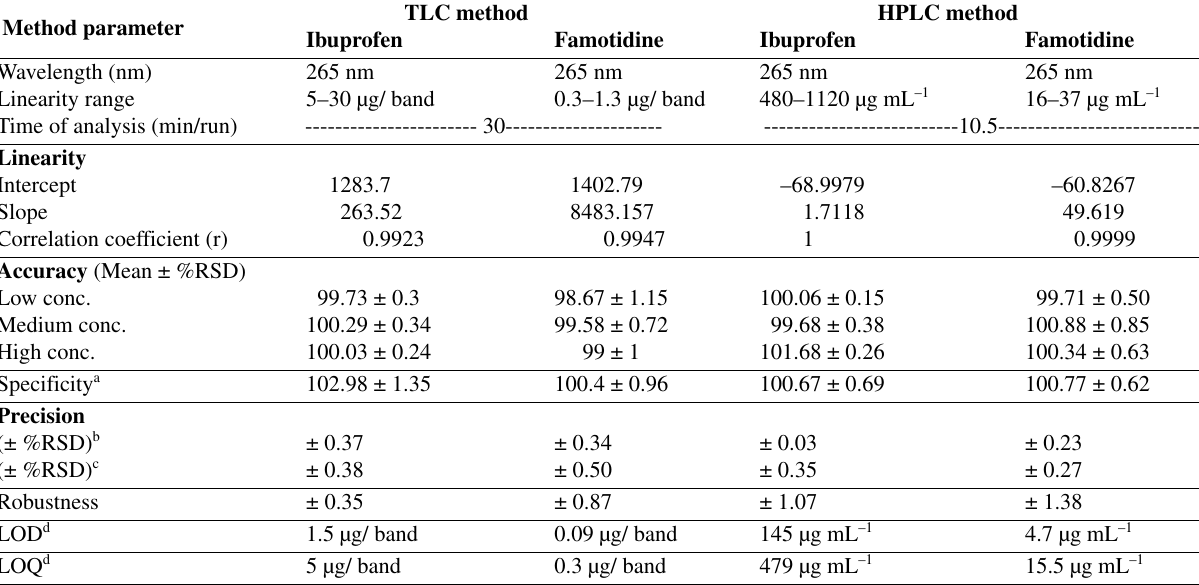
Table 1: Analytical parameters and validation results of the determination of ibuprofen and famotidine by the proposed methods Method parameter